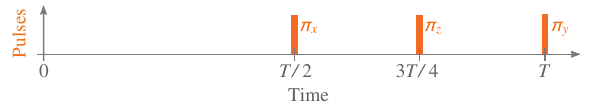
FIG. 8. The dynamical decoupling sequence to cancel inho- mogeneous broadening in the Hamiltonian (30). The π pulse about the x axis cancels disorder in the spin frequencies ω j . The subsequent π pulses about the z and y axes compensate unwanted interaction terms generated by the first π pulse. The overall pulse sequence is applied repeatedly and generates the average Hamiltonian (34) if the repetition rate 1 / T is much larger than the standard deviation of the distribution of the spin transition frequencies ω j